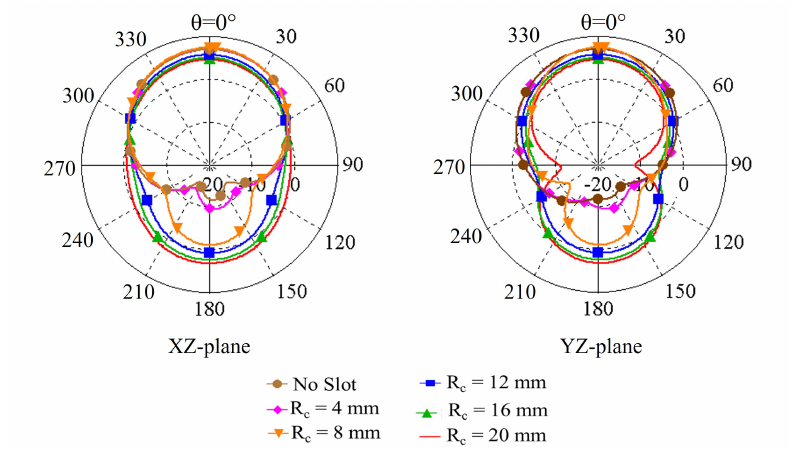
Figure 6. Radiation patterns (in dB) at the corresponding resonance frequencies when varying the radius of the slot of the ground plane. Table 2. Summary of the antenna performance when varying the radius of the slot of the ground plane.